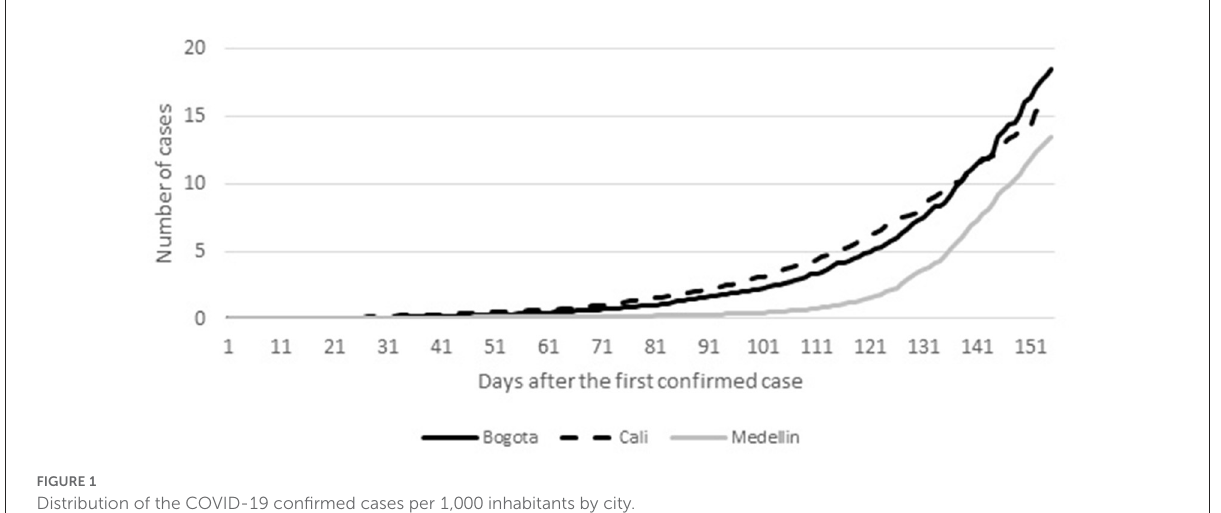
FIGURE1 Distribution of the COVID-19 confirmed cases per 1,000 inhabitants by city.